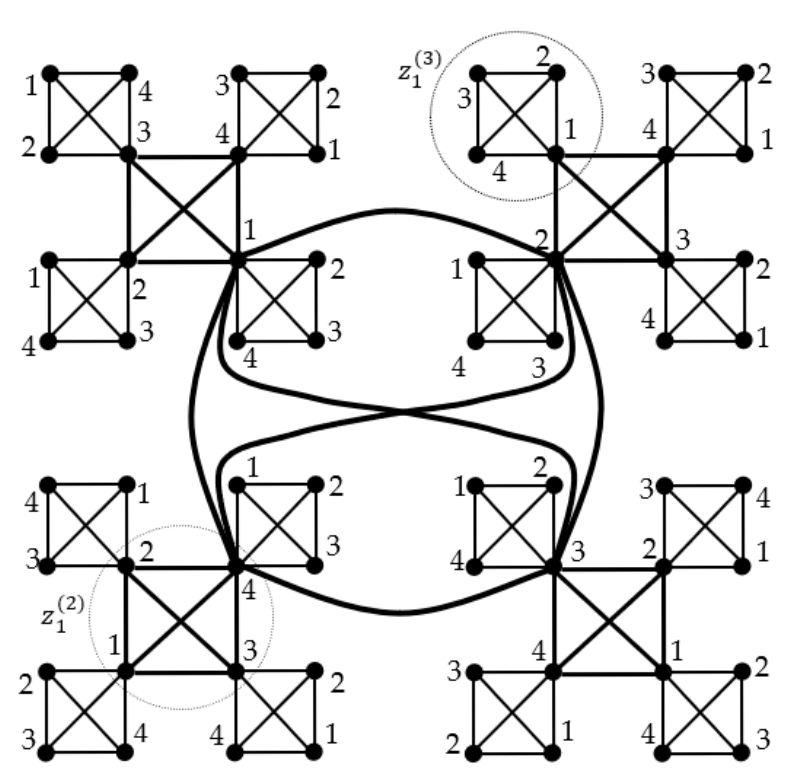
Figure 3. Minimum numbering of vertices of a prefractal graph G 3 generated by a complete 4-vertex seed, where old edges are adjacent.